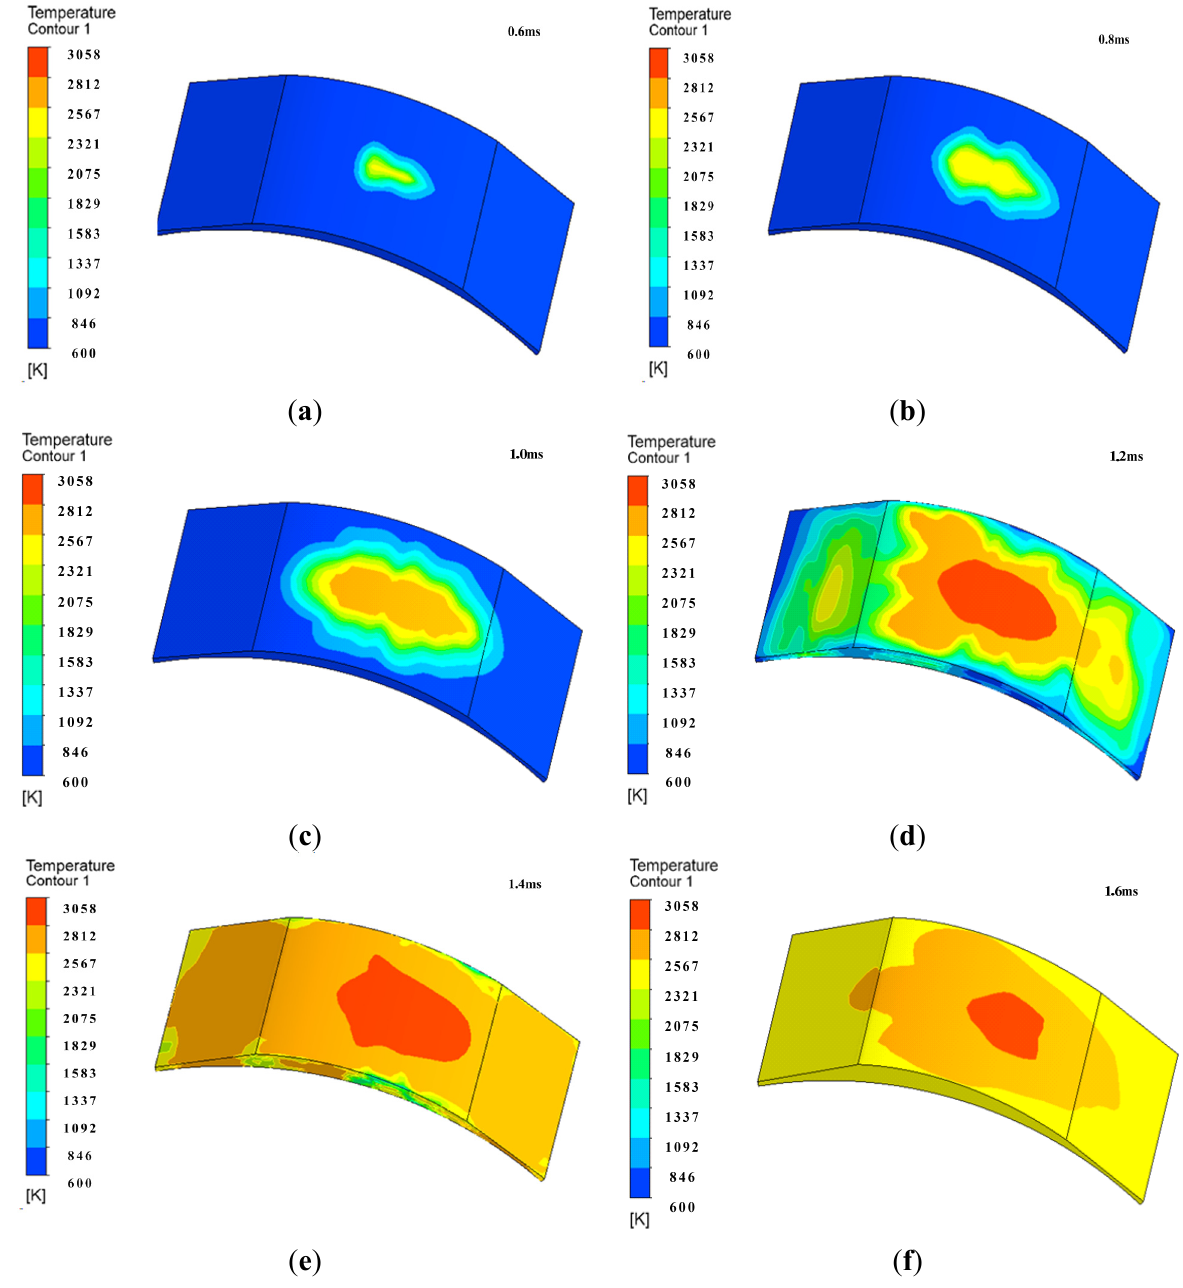
Figure 5. ( a ) Temperature field at 0.6 ms; ( b ) Temperature field at 0.8 ms; ( c ) Temperature field at 1.0 ms; ( d ) Temperature field at 1.2 ms; ( e ) Temperature field at 1.4 ms; ( f ) Temperature field at 1.6